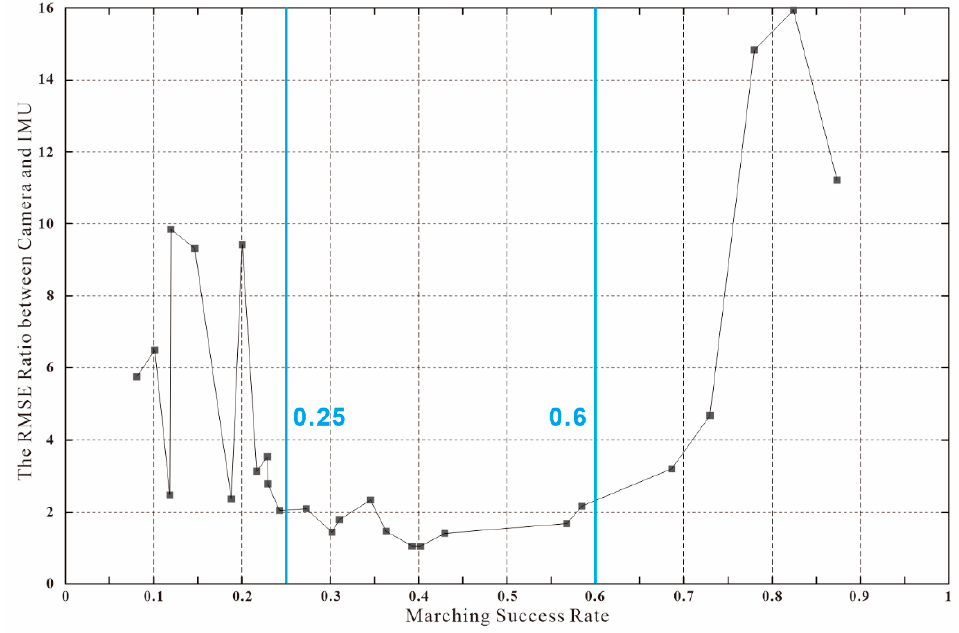
Figure 7. The relationship between the matching success rate and the pose error.